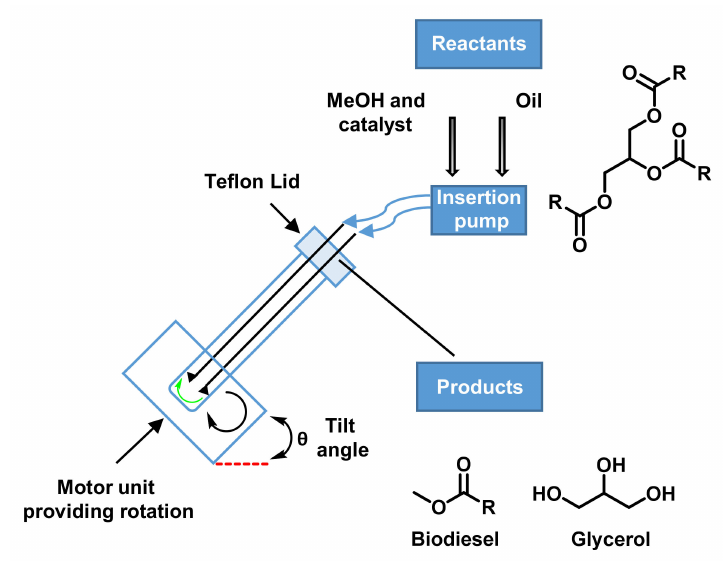
Figure 23. Vortex fluidic device (VFD).